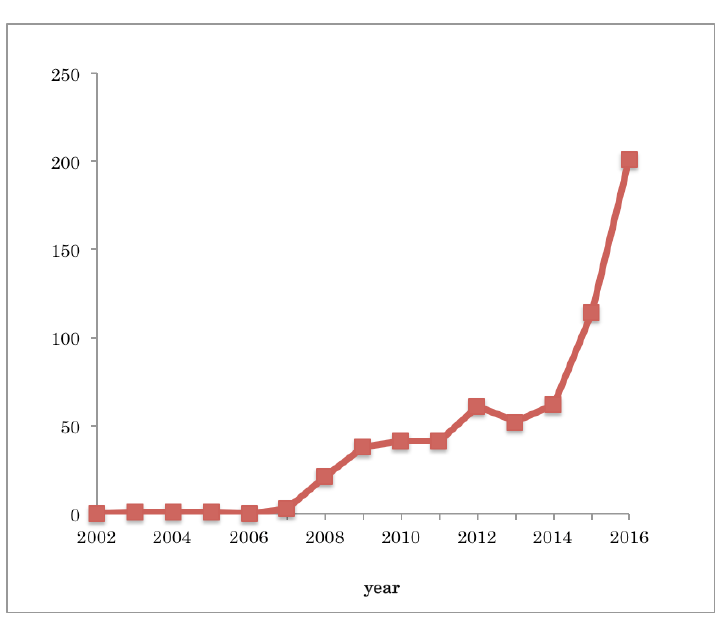
Figure 3. The number of times the term “open innovation”